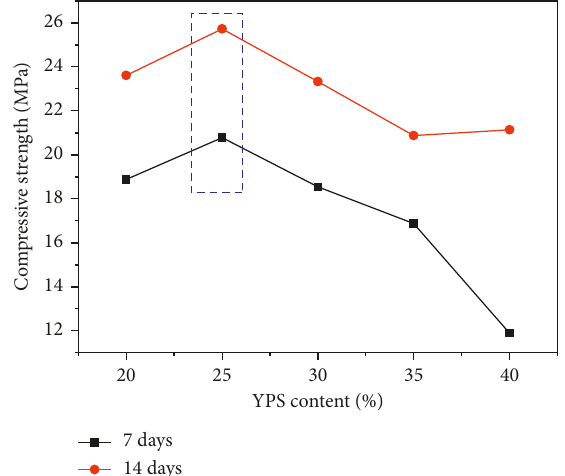
Figure 3: Compressive strength of concrete (7 and 14 days of curing) as a function of substituting YPSC for cement.